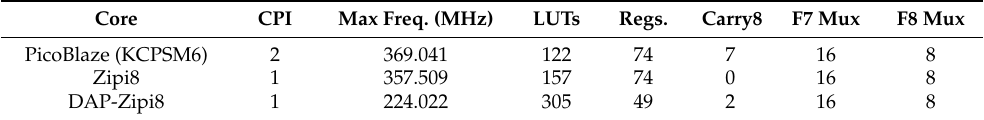
Table 3. PicoBlaze vs. Zipi8 vs. DAP-Zipi8 resource utilization and maximum clock frequency on a Xilinx ZCU104 development